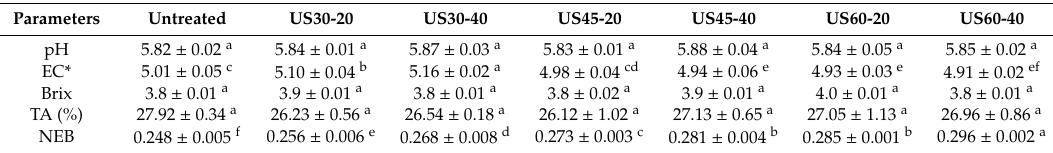
Table 7. Impact of TU treatment on physicochemical